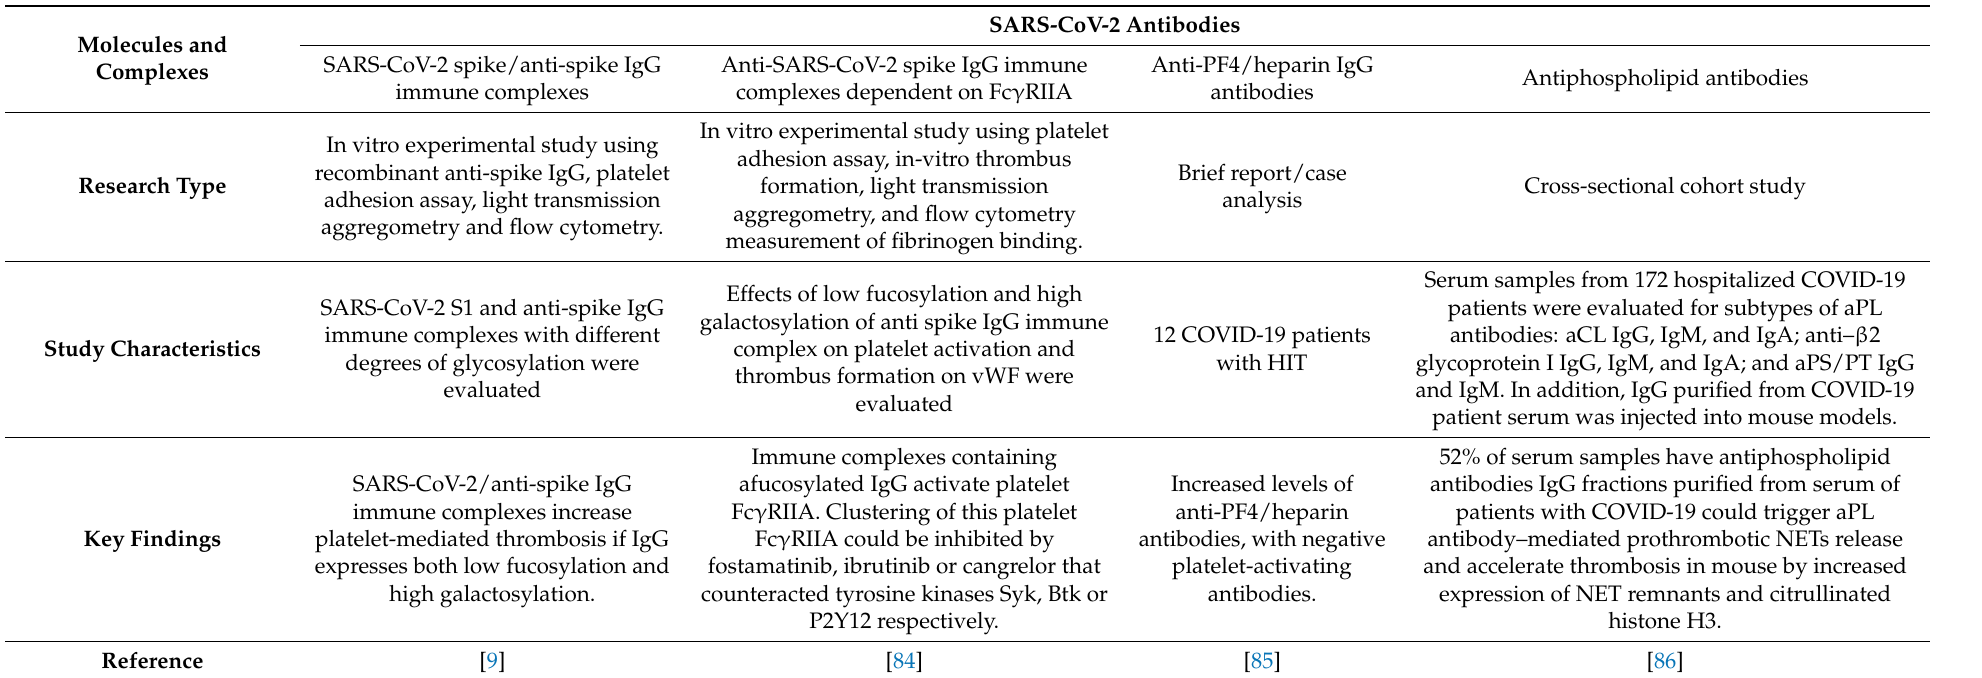
Table 2. Molecules and complexes of importance in the generation of hypercoagulability and